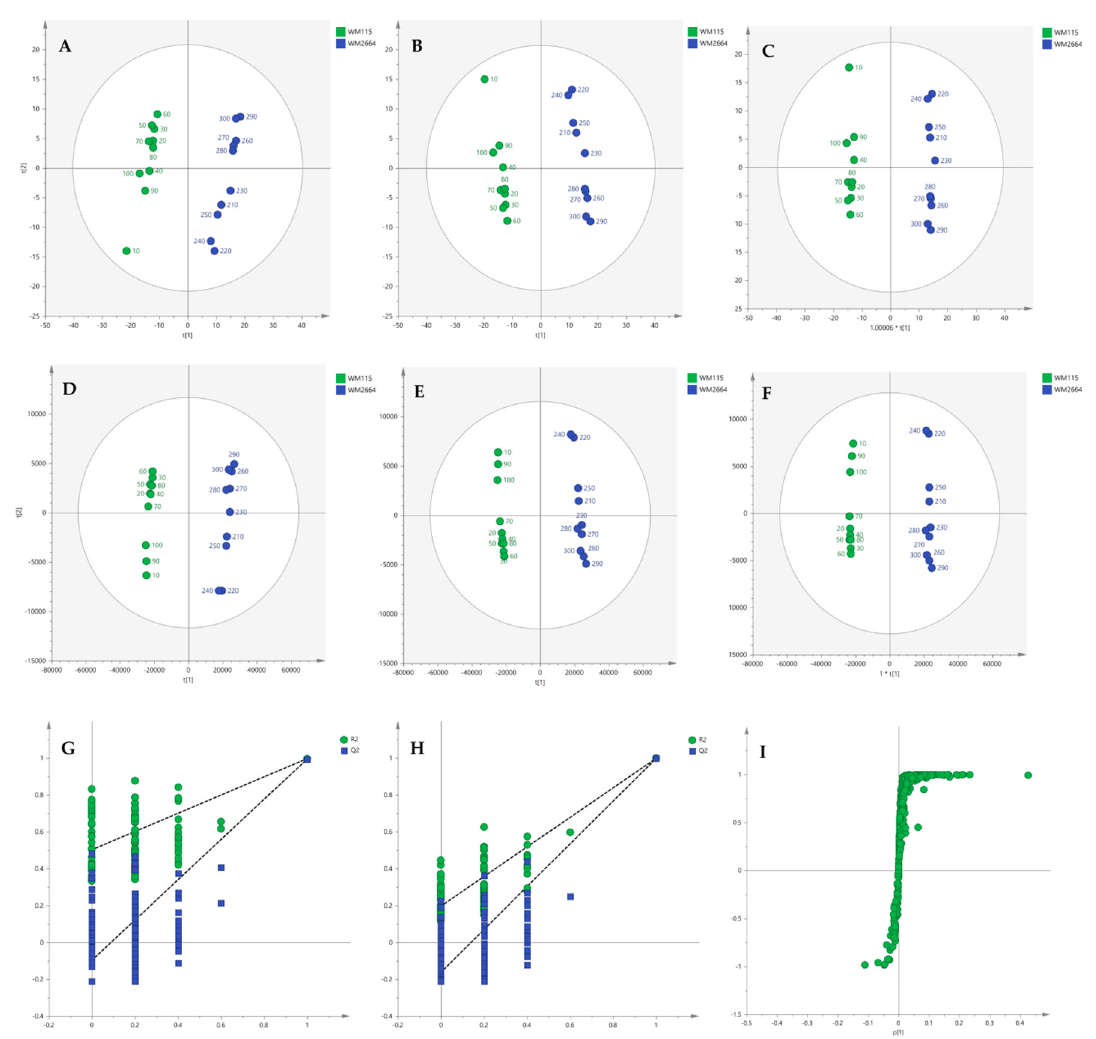
Figure 2. ( A ) PCA, ( B ) PLS-DA and ( C ) OPLS-DA score plots in UV scaling, and ( D – F ) the corresponding scores plots in Pareto scaling of NMR data. Permutation tests of PLS-DA models ( G ) in UV scaling και ( H ) in Pareto scaling. ( I ) S-plot from OPLS-DA model.